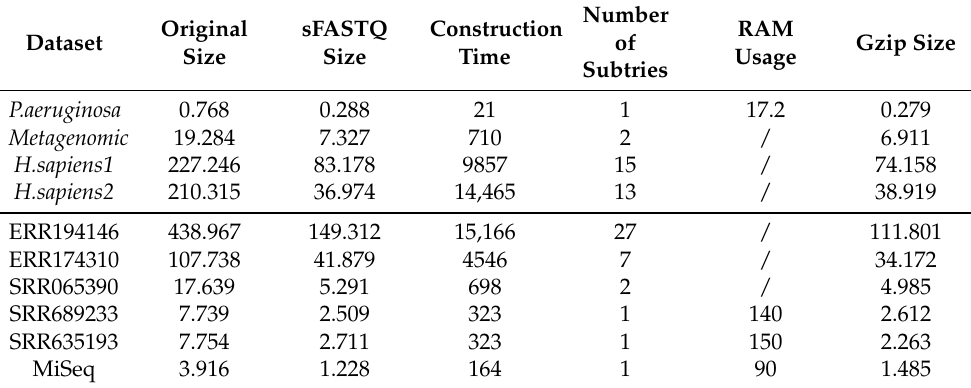
Table 1. Main compression results for paired end datasets from [3] in the first part of the Table, and [4] in the second part of the Table. Three overlapping datasets are omitted from the second part. Sizes of datasets and RAM usage are expressed in gigabytes (10 9 bytes). Construction time is given in minutes. RAM usage is reported only for datasets that fit in RAM in a single